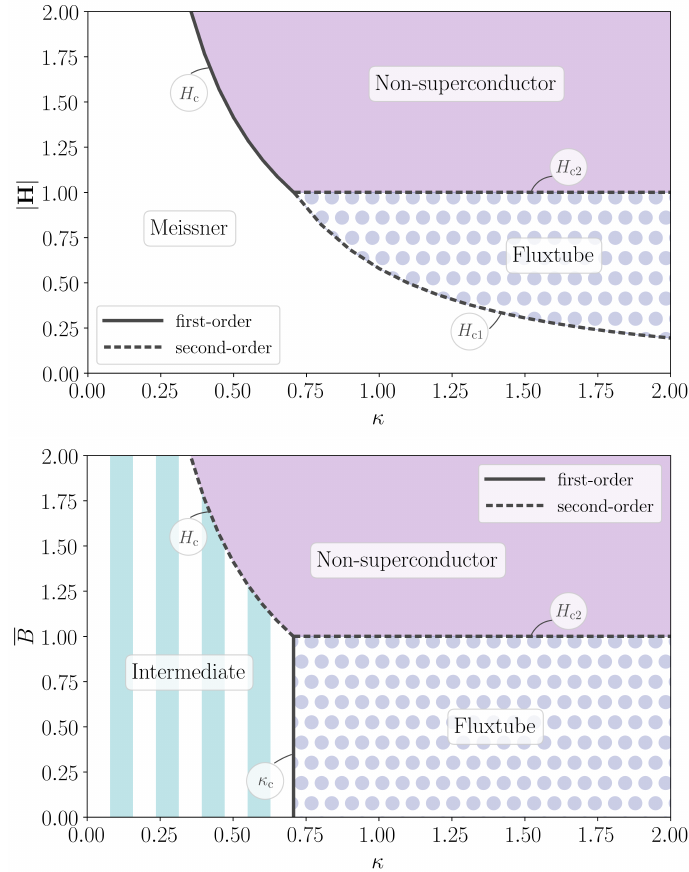
Figure 1. Phase diagrams for a one-component Ginzburg–Landau superconductor, for different values of the Ginzburg–Landau parameter, κ . The top panel shows the experiment with an imposed H external field, , in our nondimensional units. The first-order and second-order transitions at the | | different critical fields are indicated by solid and dashed black lines, respectively, and the resulting phases labeled accordingly. Shading of the respective regions is indicative of the magnetic flux distribution. The bottom panel shows the phase transitions in the experiment with an imposed mean flux, B . For more details see the